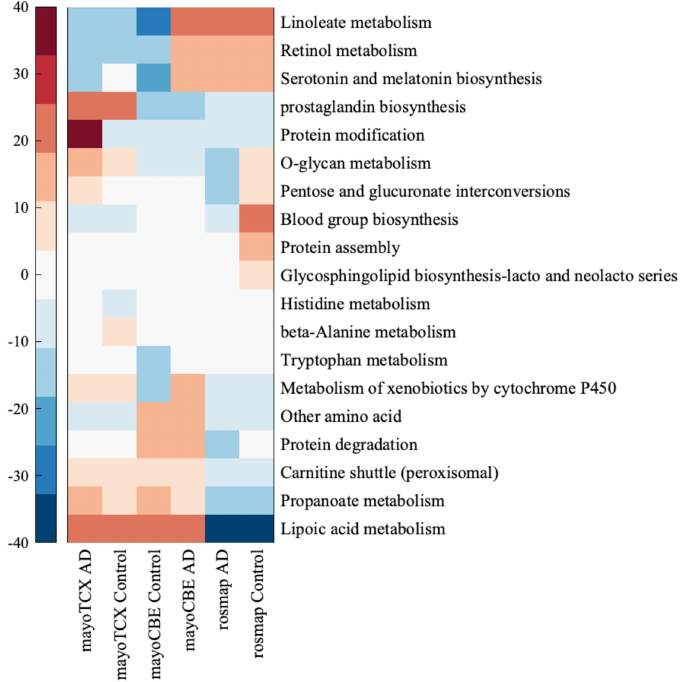
Figure 7. Heatmap for metabolic pathways expressed at least 10% differently in one group of samples. Each colour tone closer to blood-red refers to 10% increase compared to other metabolic pathways, while each colour tone closer to deep blue 10% decrease compared to other metabolic